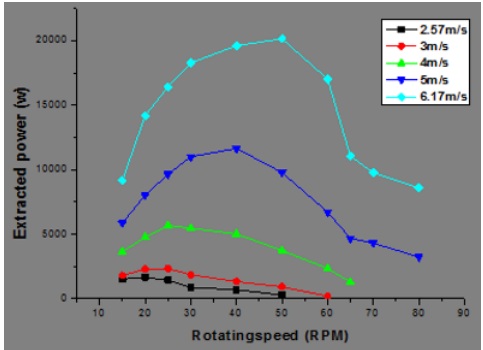
Figure 8. Extractedpowervariationwithinletflowspeedandrotating speed.